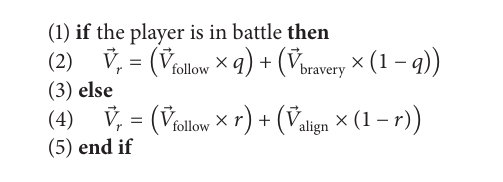
Algorithm 1: Apply